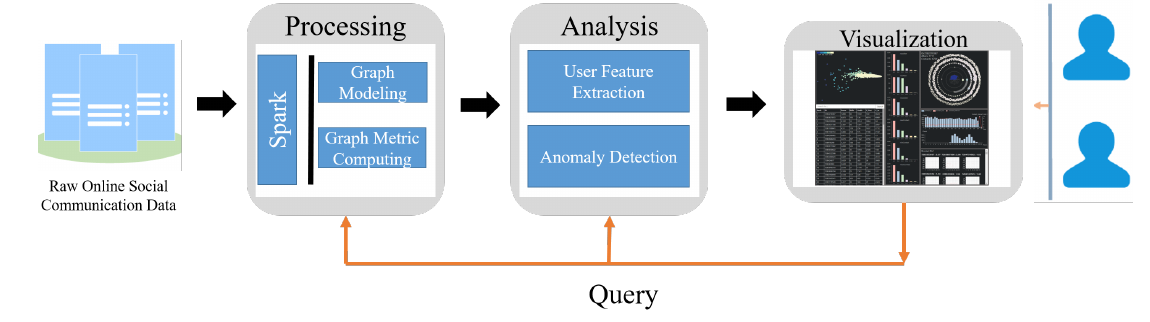
Figure 3. The data processing